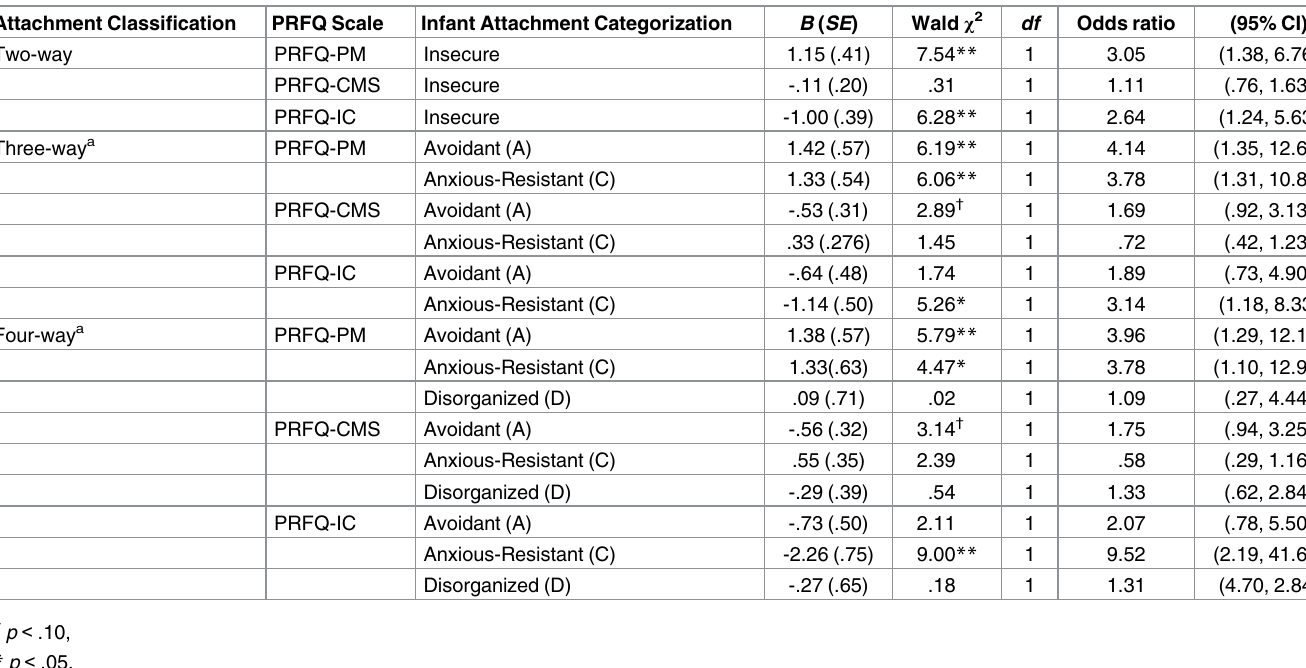
Table 11. The relationship between maternal parental reflective functioning and two-, three- and four-way infant attachment classification. Attachment